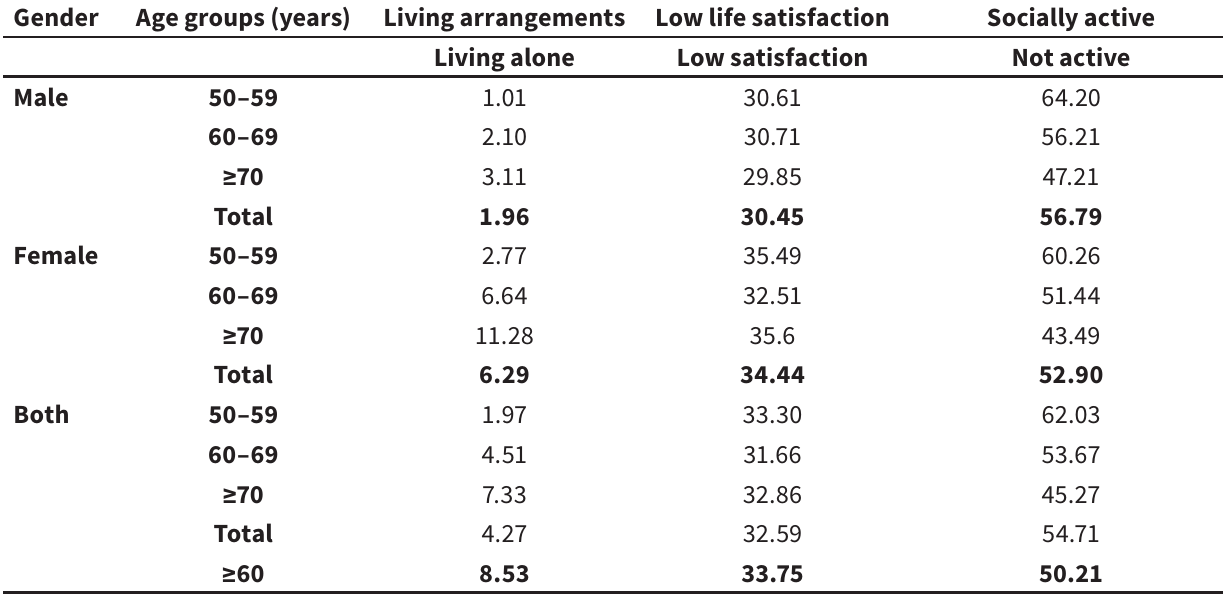
Life satisfaction and living arrangements of the aging population in India (LASI-2017-18). Gender Age groups